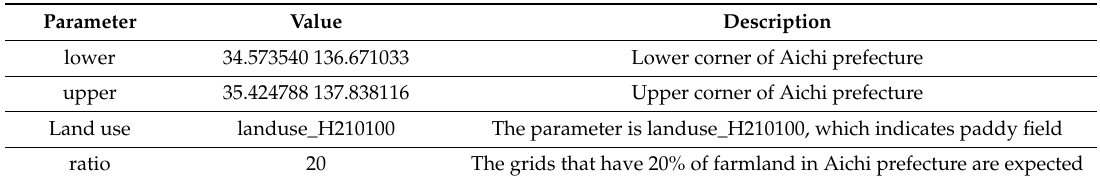
Table 8. List of Mesh Info API parameters for pre-caching